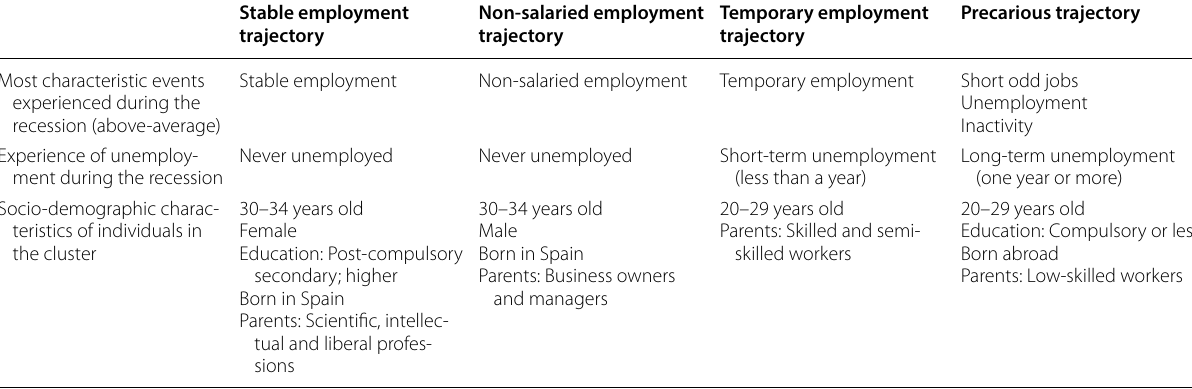
Source: Elaborated by